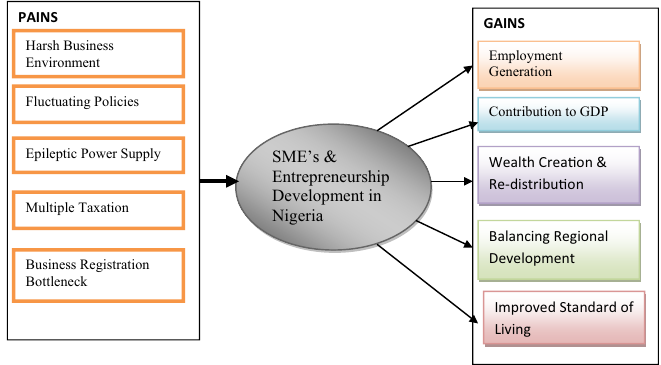
Figure 1. The pains and gains